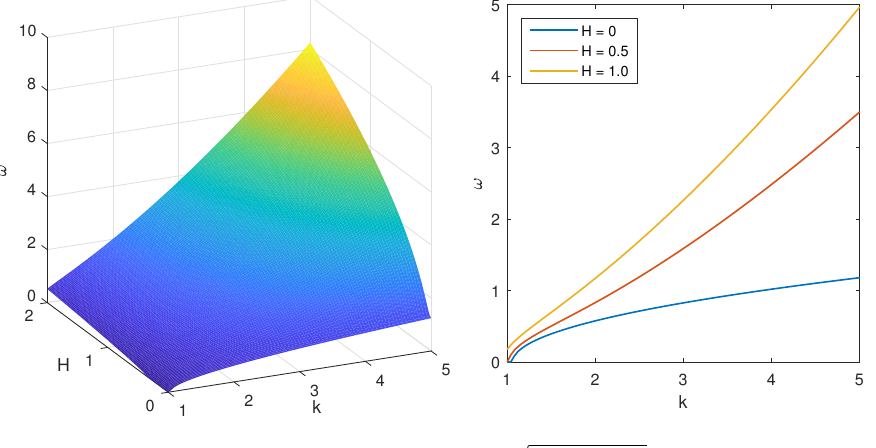
Figure 3. The plot of dispersion relation, where k =